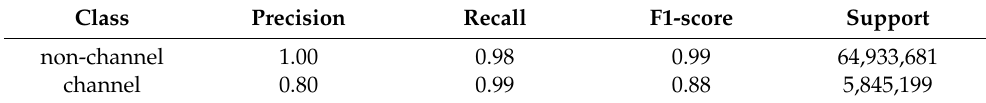
Table 8. The classification report for the validation process on real seismic data. Class Precision Recall F1-score Support non-channel 1 0.97 0.99 6,973,876 channel 0.83 0.99 0.90